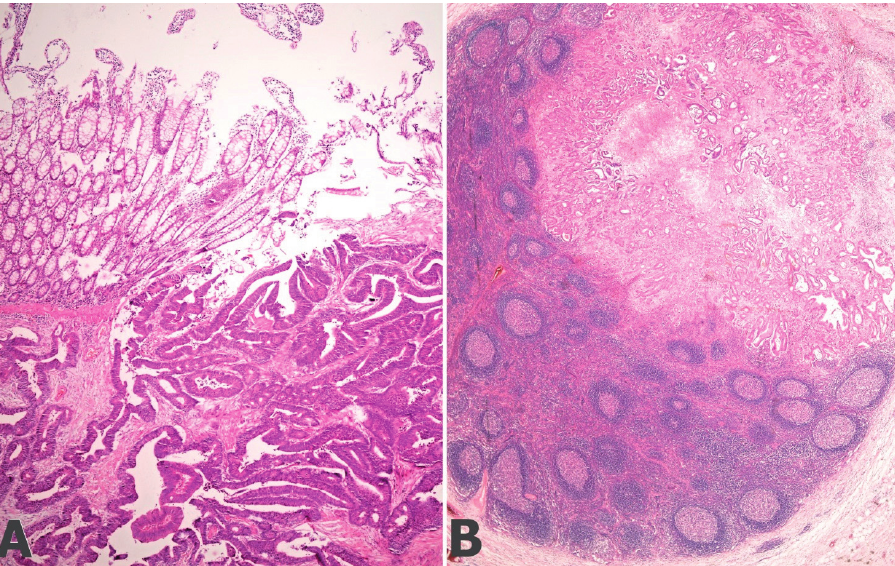
Fig. 3. Border between normal large bowel mucosa (left) and moderately differentiated colorectal carcinoma (right) (40x, H&E) (A). The lymph node with metastasis of colorectal carcinoma (20x, H&E)